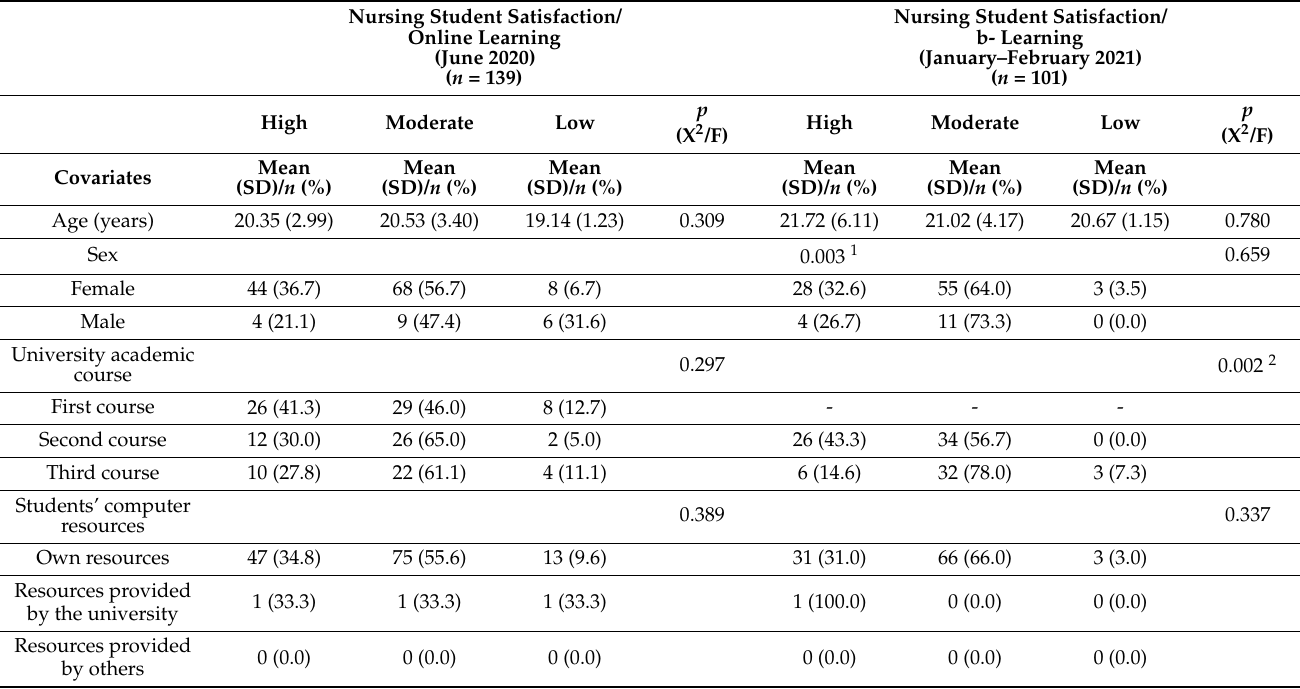
Table 3. Bivariate analysis. Covariates and nursing student satisfaction (online learning and